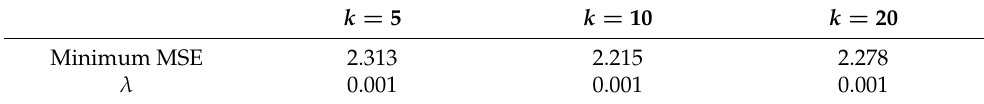
Table 1. The optimal penalty term at different k in the Chlorella vulgaris microalgae dataset. k = 5 k = 10